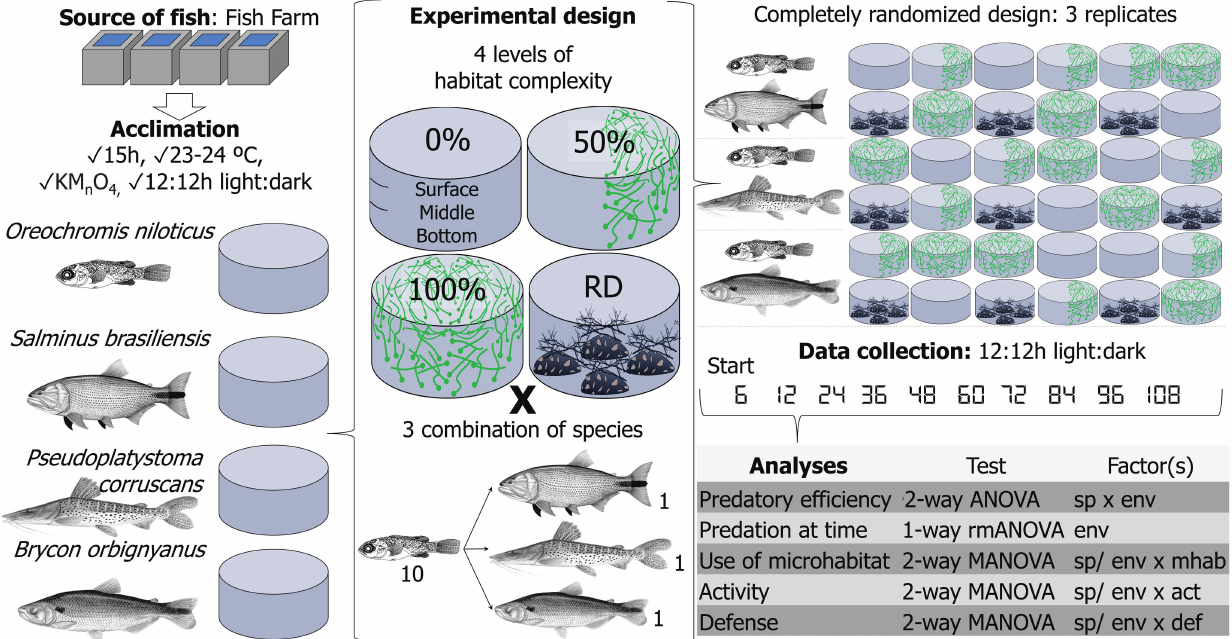
Fig. 2 . Summary of scheme of experimental procedures, design and statistical analyses. From left to right: acclimatization period and procedures for each species in isolation ( Oreochromis niloticus , Salminus brasiliensis , Pseudoplatystoma corruscans and Brycon orbignyanus ). Experimental design: four levels of habitat complexity (0%, 50% and 100% (simulated using green plastic filaments) and RD (rocks and driftwood) simulated with basaltic rocks and tree branches) for three species combinations ( O. niloticus x S. brasiliensis , O. niloticus x P. corruscans and O. niloticus x B. orbignyanus ), replicated three times, totaling 36 experimental units. Ten O. niloticus were placed in each tank and after 6 h, one predator was added. Data collection started 6 h from the beginning of the experiment and was repeated at 12-h intervals (5 a.m./5 p.m.). The predatory efficiency, predation frequency over time, use of microhabitat and activity by predators and prey, together with the defense strategy of the prey, were analyzed using different models of ANOVA